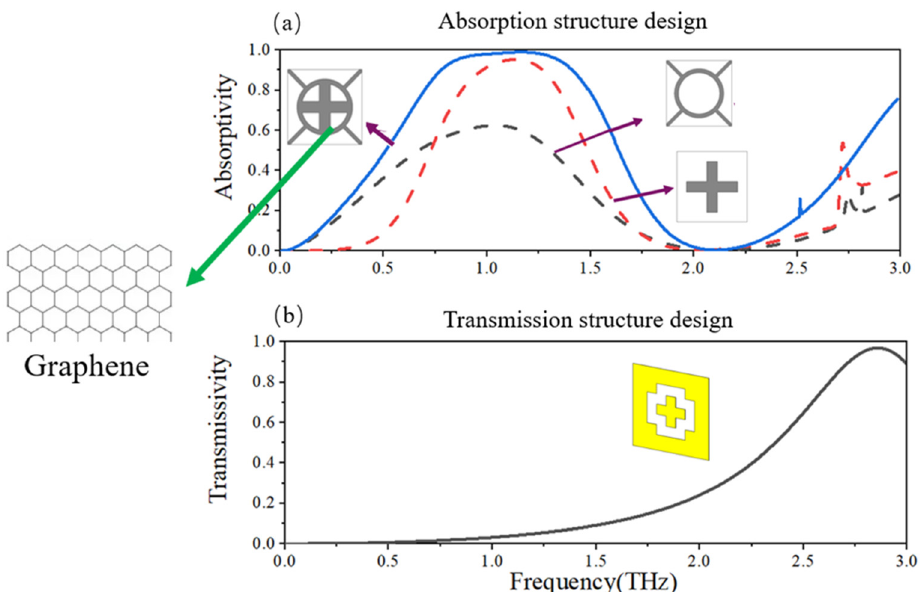
Figure 1. ( a ) The broadband absorption graphene metamaterial structure design; ( b ) The frequency selective transmission structure design.